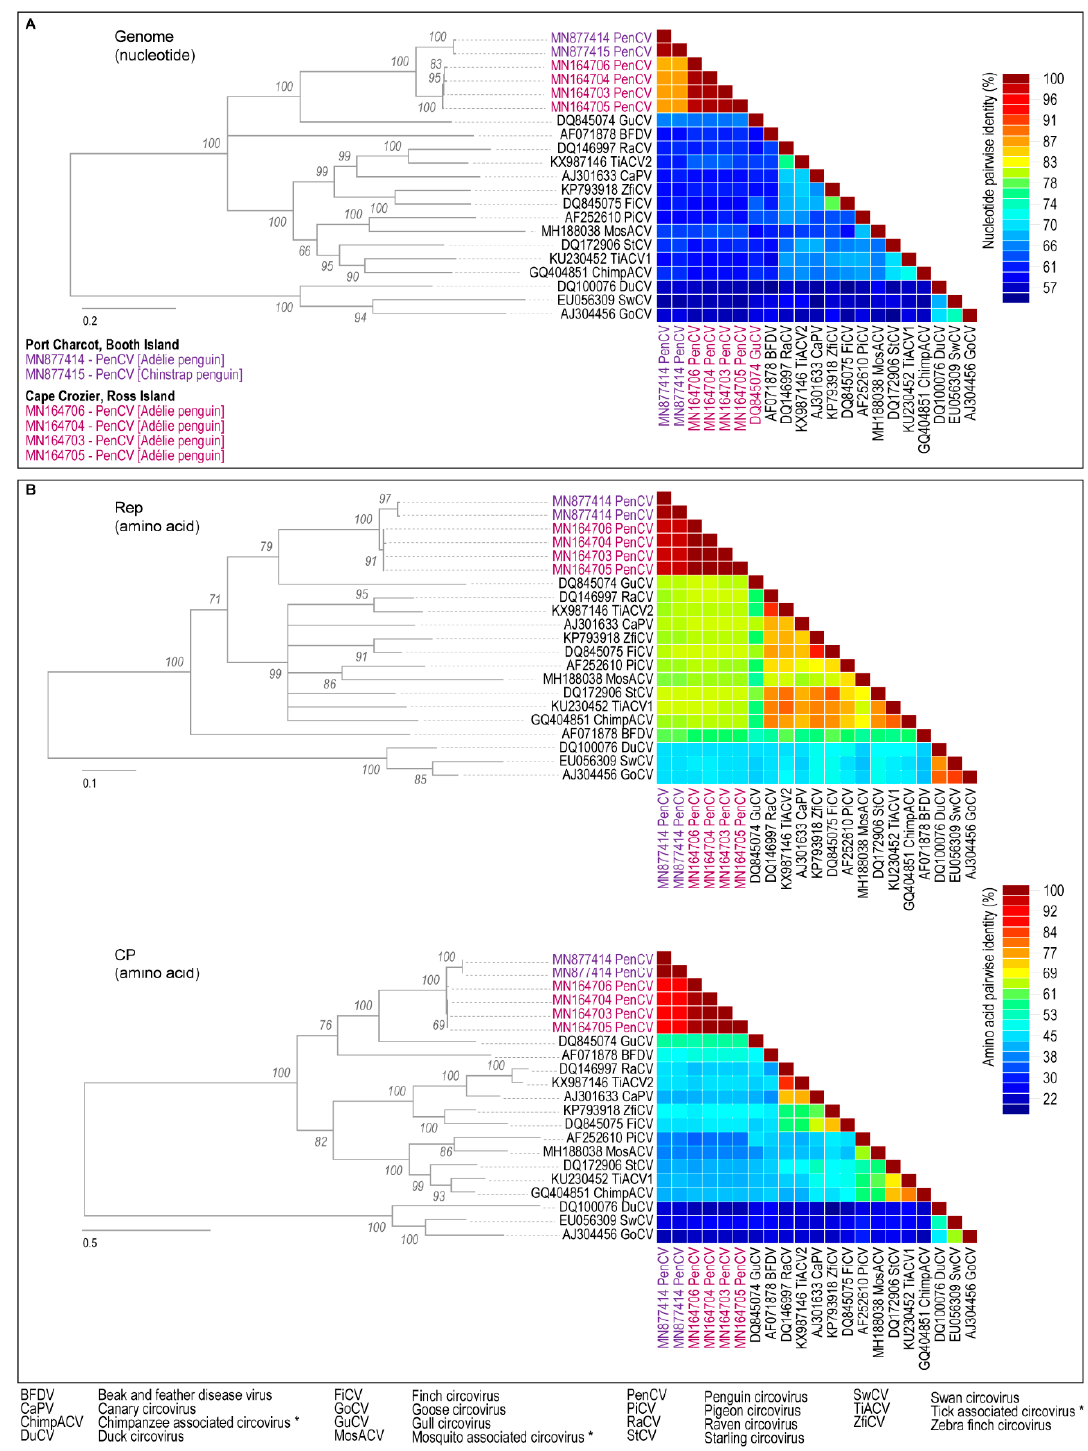
Figure 2. (A) Maximum ‐ likelihood phylogenetic tree based on the genomic sequences of PenCVs and other avian circoviruses with a color ‐ coded nucleotide pairwise identity matrix. ( B ). Maximum ‐ likelihood phylogenetic trees of the Rep and CP amino acid sequences encoded by PenCVs with corresponding color ‐ coded amino acid pairwise identity matrixes. Branches with < 60% support have been collapsed, and the trees are rooted with sequences of duck circovirus (DuCV), goose circovirus (GoCV), and swan circovirus (SwCV). * Viruses likely infect avian species, but they have been identified in fecal samples and insect vectors.